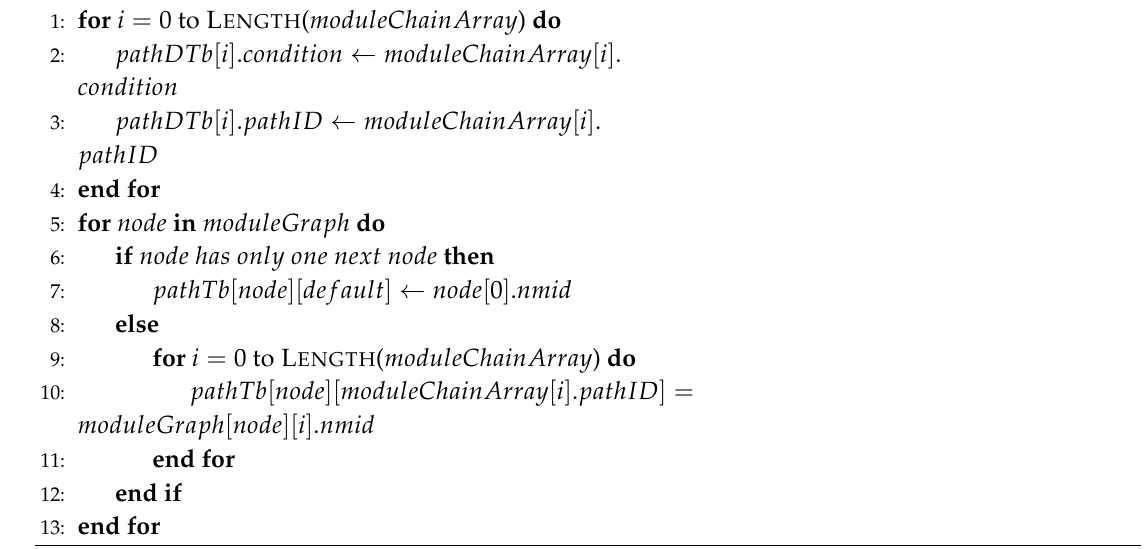
Algorithm 2 Generate path information based on module chains and module